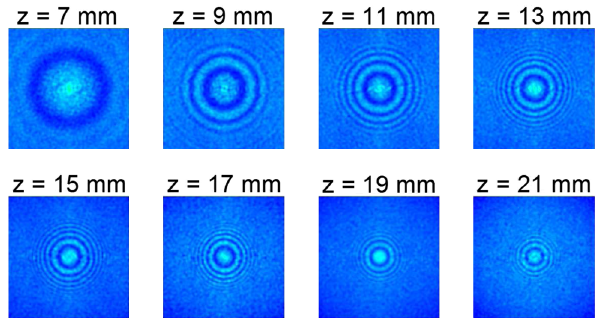
FIG. 11. Raw power spectra in narrowband conditions. Perfect azymuthal symmetry is a clear signature of predominant temporal coherence, as discussed in Sec. II B.